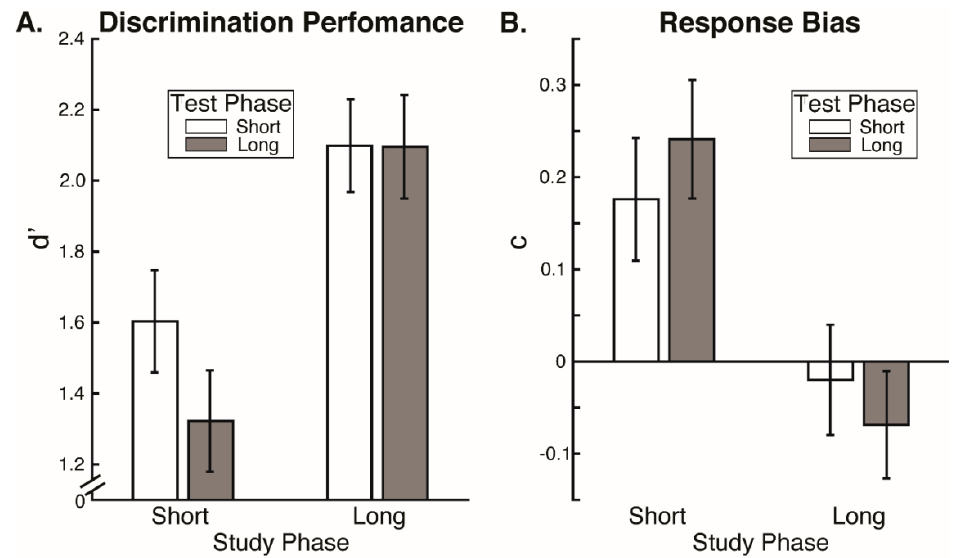
Figure 3. Recognition performance. ( A ) Discrimination performance was reduced for faces that had been studied for only one second compared to those that had been studied for five seconds and ( B ) Response bias indicated that the short study phase stimulus presentation time elicited more conservative criteria to report that a face was recognized than did long study phase stimulus presentation